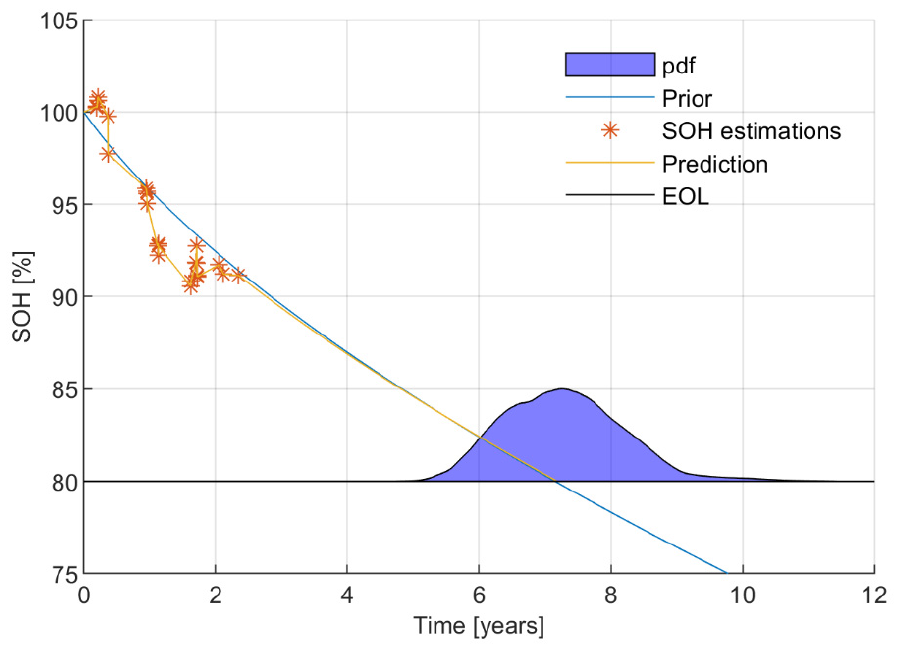
Figure 5. Example of a prognosis. A stochastic particle filter is based on a Monte Carlo algorithm. It consists of a randomly generated finite number of particles to find the posterior distribution given a noise process and some partial observations. It allows for the filtering of the noise that hides the actual trend underneath the data. Once the trend is obtained and there are no more observations (SOH estimations), the trend and its distribution are propagated until the EOL is reached. As results, the RUL and its pdf are predicted